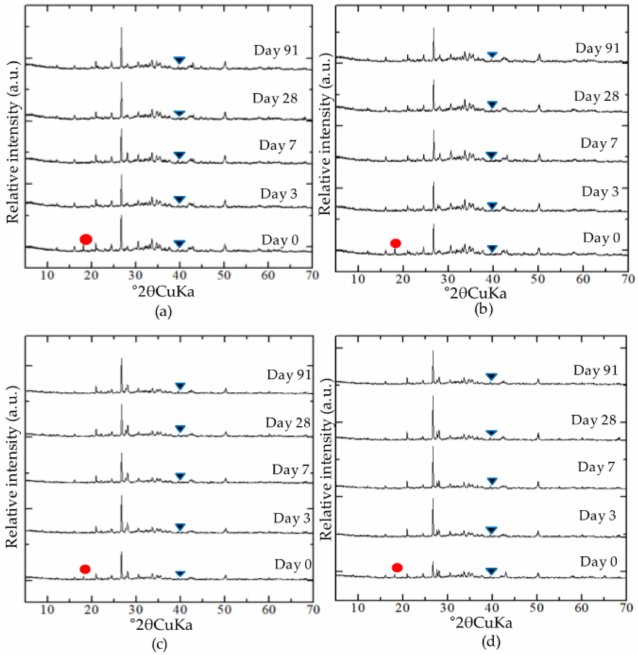
Figure 8. XRD profiles of mixtures cured for 0, 3, 7, 28 and 91 days of ( a ) mixture 1A, ( b ) mixture 1B, ( c ) mixture 1C, and ( d ) mixture 1D. Red circle corresponds to portlandite and black triangle corresponds to